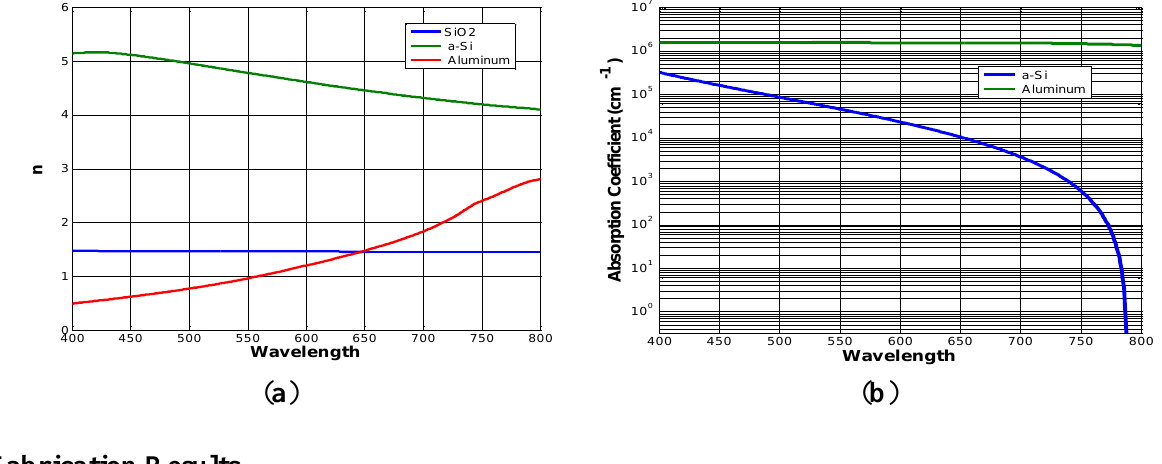
Figure 10. (a) Refractive index, n , of the different materials used in the back reflector; (b) log plot of absorption coefficient data for the a-Si and aluminum materials used in the